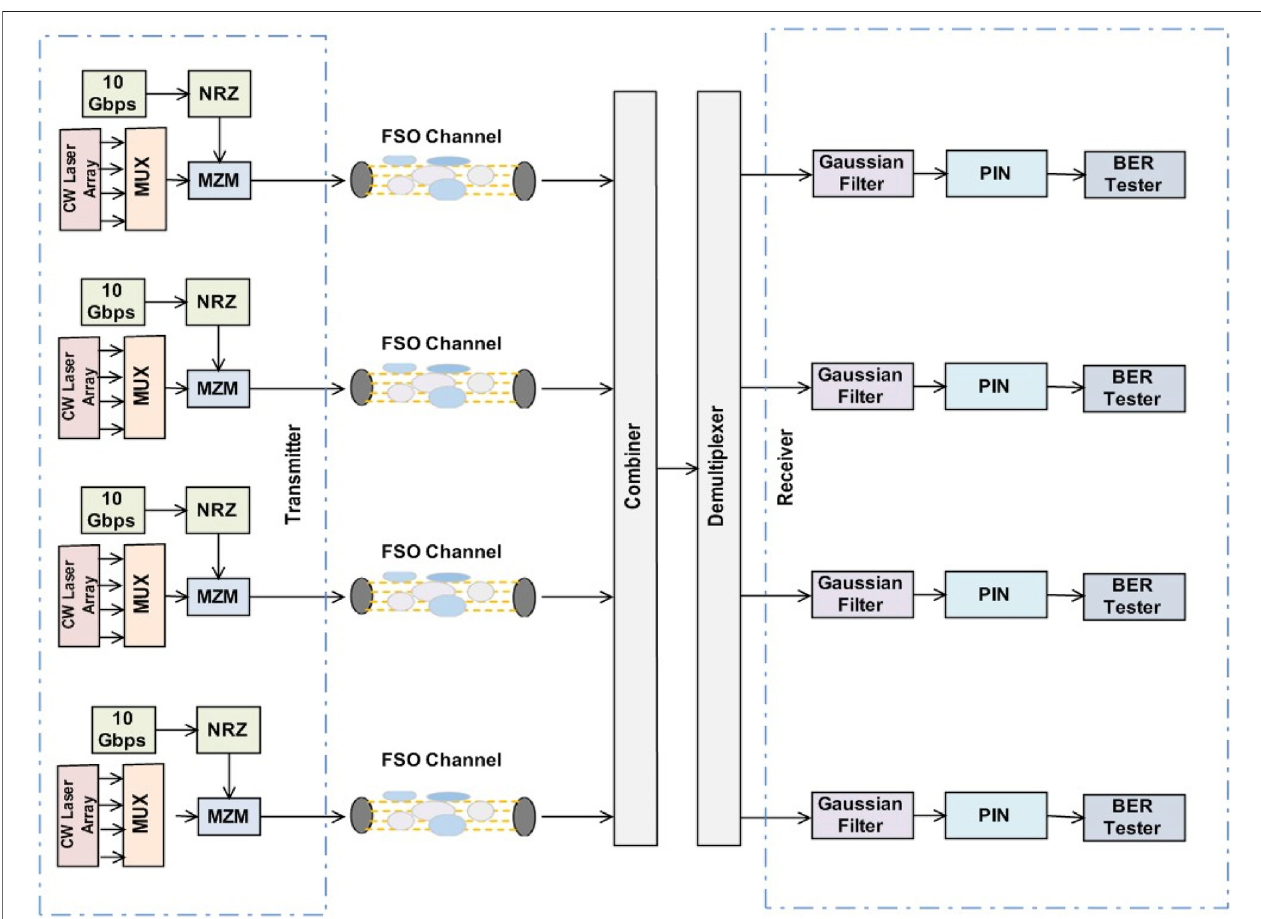
FIGURE 5 | Proposed system layout of an MIMO FSO communication setup.